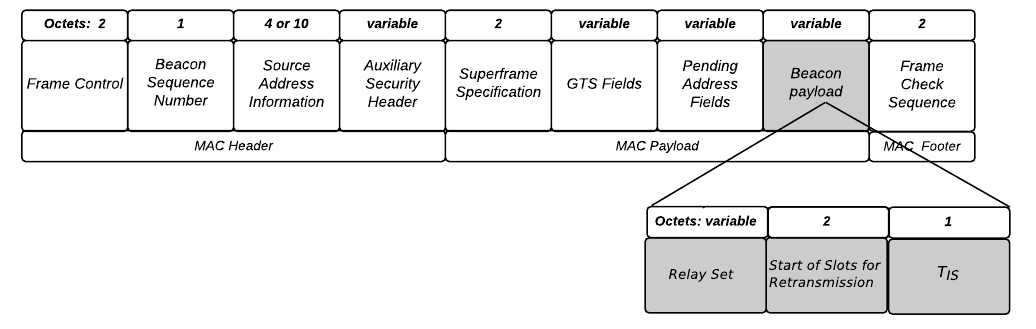
Figure 3. Beacon frame